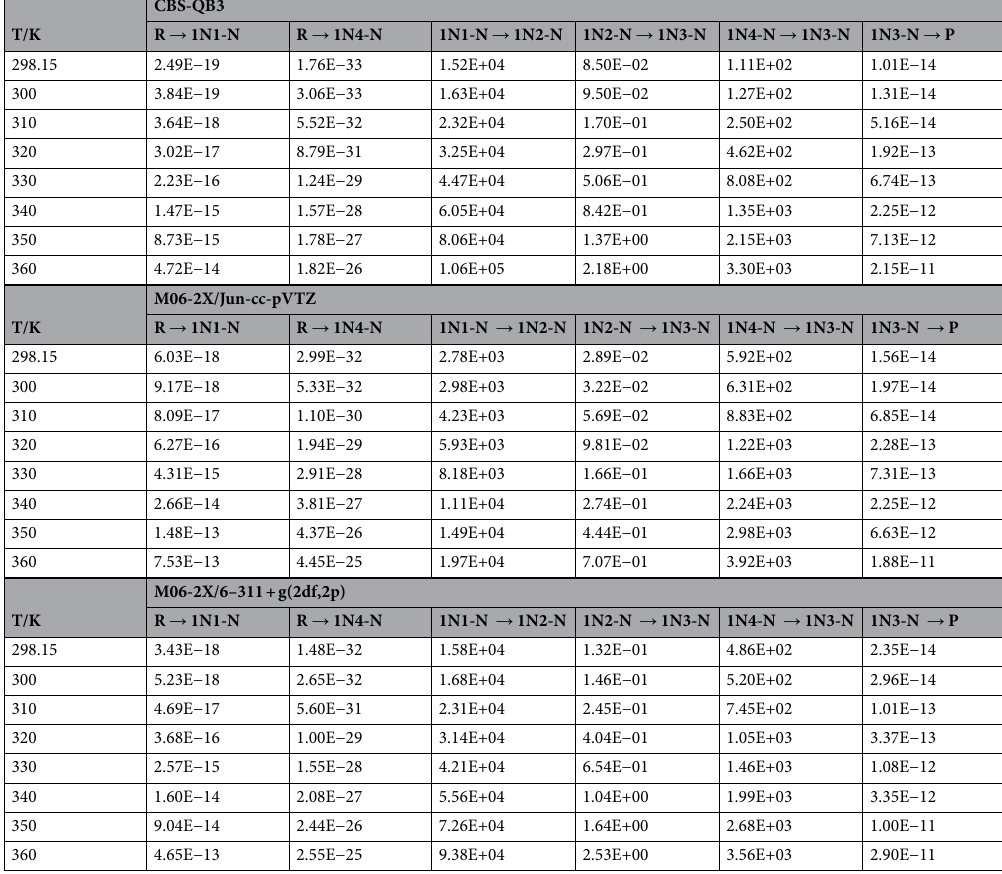
Table 2. Unimolecular rate constants (s −1 ) calculated by RRKM theory at the CBS-QB3, M06-2X/Jun-cc- pVTZ, and M06-2X/6-311 + g(2df,2p) levels for all channels of 1,4-H shift of